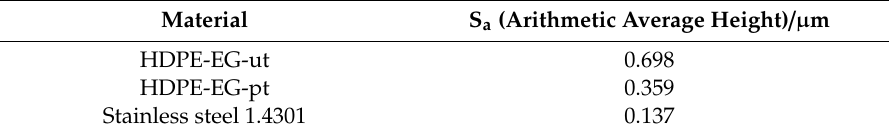
Figure 9. AFM surface profile of HDPE-EG50 composite ( a ) before and ( b ) after plasma treatment. Table 2. Arithmetical mean heights of the investigated samples (surface roughness).